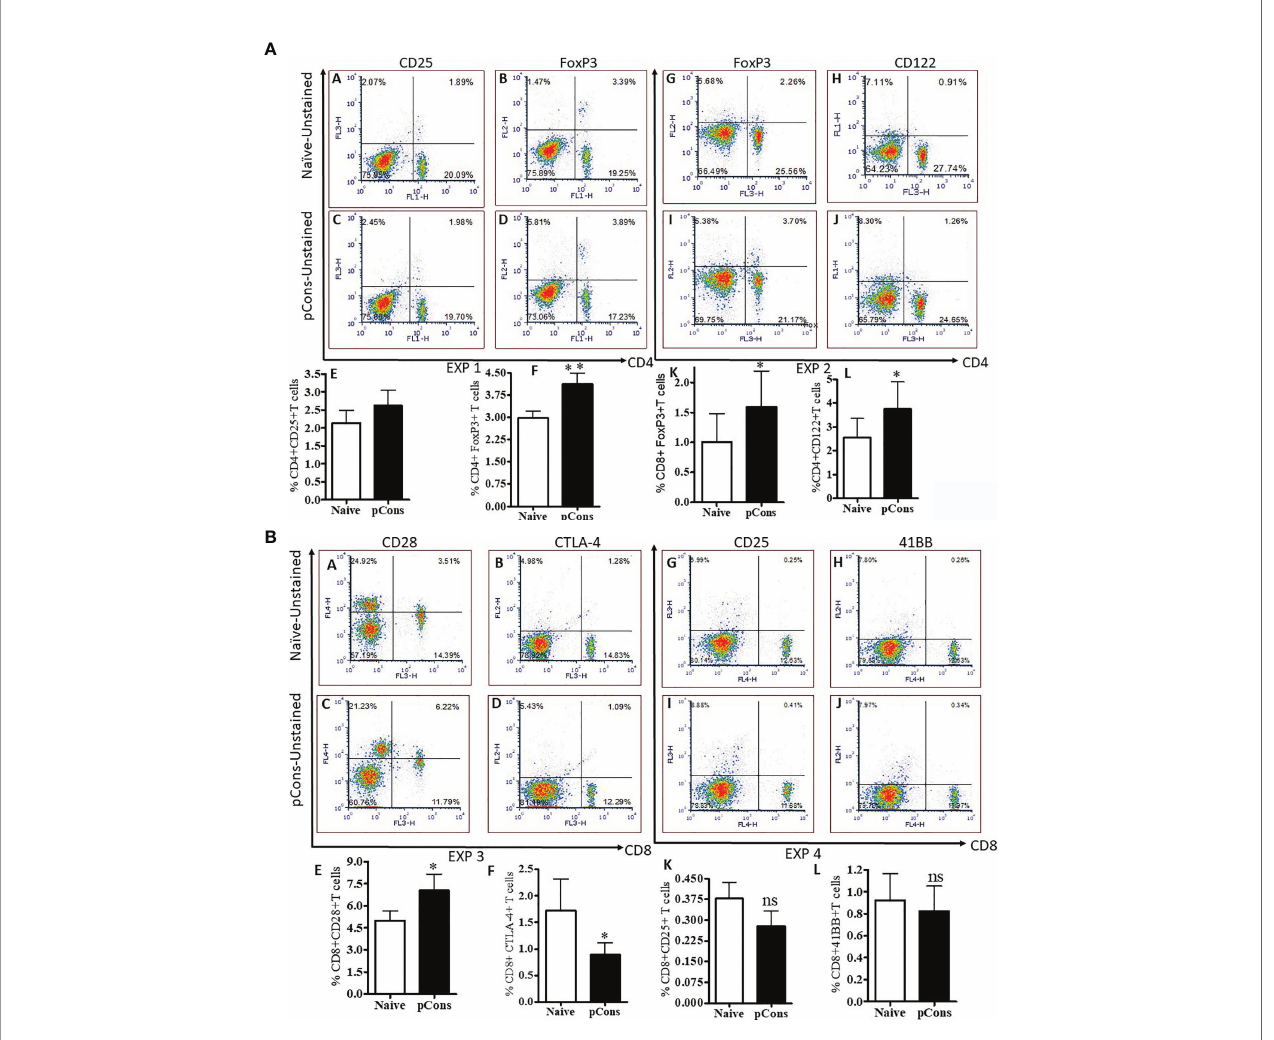
FIGURE 1 | pCons treatment alters cell surface expression of CD25, CD122, and increased intracellular FoxP3 expression in CD4 + T cells and further modi fi es cell surface expression of CD25, CD28, CTLA-4 and 41BB in CD8 + T cells in BWF1 mice. Female 10-12-wk old BWF1 mice were treated with pCons (1 mg i.v .). After one-two week treatment, splenocytes were obtained both from naïve and pCons-treated BWF1 mice. RBC were lysed, cells washed, and stained with fl uorochrome-labeled speci fi c antibodies (CD4, CD8, CD25, CD28, CD122, CTLA-4, and 41BB). FACS analysis was performed on a FACSCalibur ™ with cell Quest ™ software (BD Biosciences, San Jose, CA) and analyzed using De Novo FCS Express software (Ontario, Canada). Intracellular FoxP3 expression was analyzed after cell fi xation and permeabilization as per manufacturer ’ s protocol (eBiosciences, San Diego, CA, USA). (A) CD4 + T cells, and (B) CD8 + T cells data, two experiments each. (A) Exp 1. Panel (A) Naïve CD4 + CD25 + T cells; (B) Naïve CD4 + FoxP3 + T cells; (C) pCons CD4 + CD25 + T cells; (D) pCons CD4 + FoxP3 + T cells. (E) Cumulative data of CD4 + CD25 + T cells (4-5 experiments of two/three mice); (F) Cumulative data of CD4 + FoxP3 + T cells (4-5 experiments of two/three mice). Exp 2. (G) Naïve CD4 + FoxP3 + T cells; (H) Naïve CD4 + CD122 + T cells; (I) pCons CD4 + FoxP3 + T cells., (J) pCons CD4 + CD122 + T cells. (K) Cumulative data (6 experiments) of CD8 + FoxP3 + T cells. (L) Cumulative data of CD4 + CD122 + T cells (4 experiments of two/three mice). (B) Exp 3. (A) Naïve CD8 + CD28 + T cells; (B) Naïve CD8 + CTLA-4 + T cells; (C) pCons CD8 + CD28 + T cells; (D) pCons CD8 + CTLA-4 + T cells. (E) Cumulative data of CD8 + CD28 + T cells (5-6 experiments). (F) Cumulative data of CD8 + CTLA-4 + T cells (5-6 experiments). Exp.4. (G) Naïve CD8 + CD25 + T cells; (H) Naïve CD8 + 41BB + T cells, (I) pCons CD8 + CD25 + T cells; (J) pCons CD8 + 41BB + T cells. (K) Cumulative (6-7 experiments data) of CD8 + CD25 + T cells, (L) Cumulative (4 experiments data) of CD8 + 41BB + T cells. Minimum 10,000 cells were gated, and only live cells were used for data analyses. Dead cells were excluded from the analyses. *p < 0.05. **p < 0. 001. ns, not signi fi